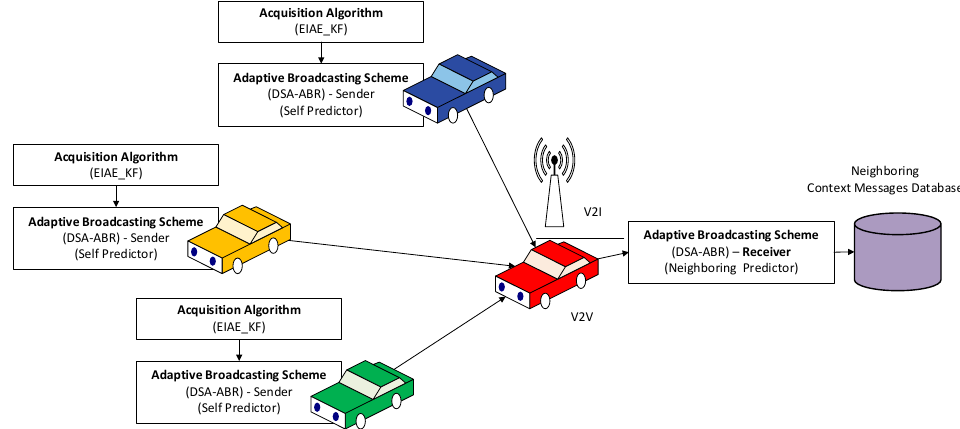
Figure 4. Dataset collection from neighboring vehicles.